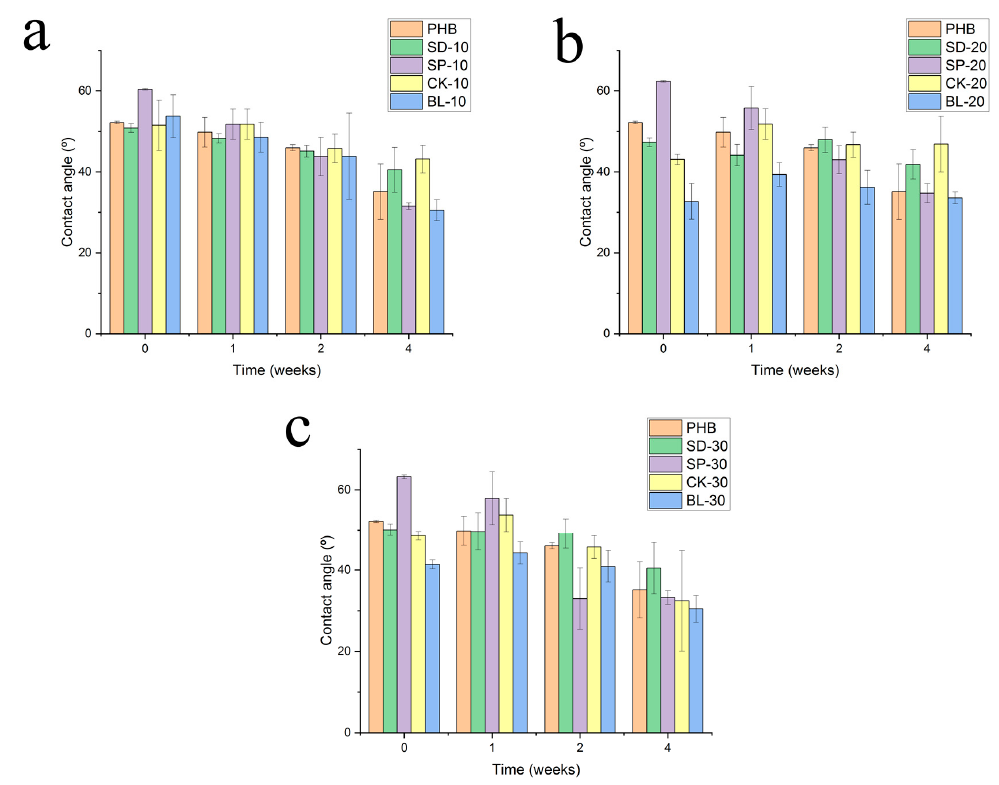
Figure 4. Evolution of the contact angle of composites with the exposure time on Xenotest. Reinforcement: ( a ) 10%, ( b ) 20% and ( c ) 30%.